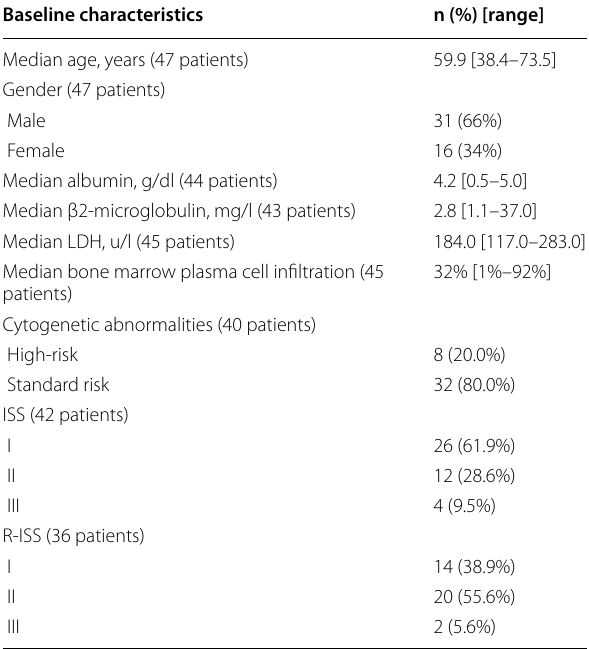
Table 1 Baseline patient characteristics Baseline